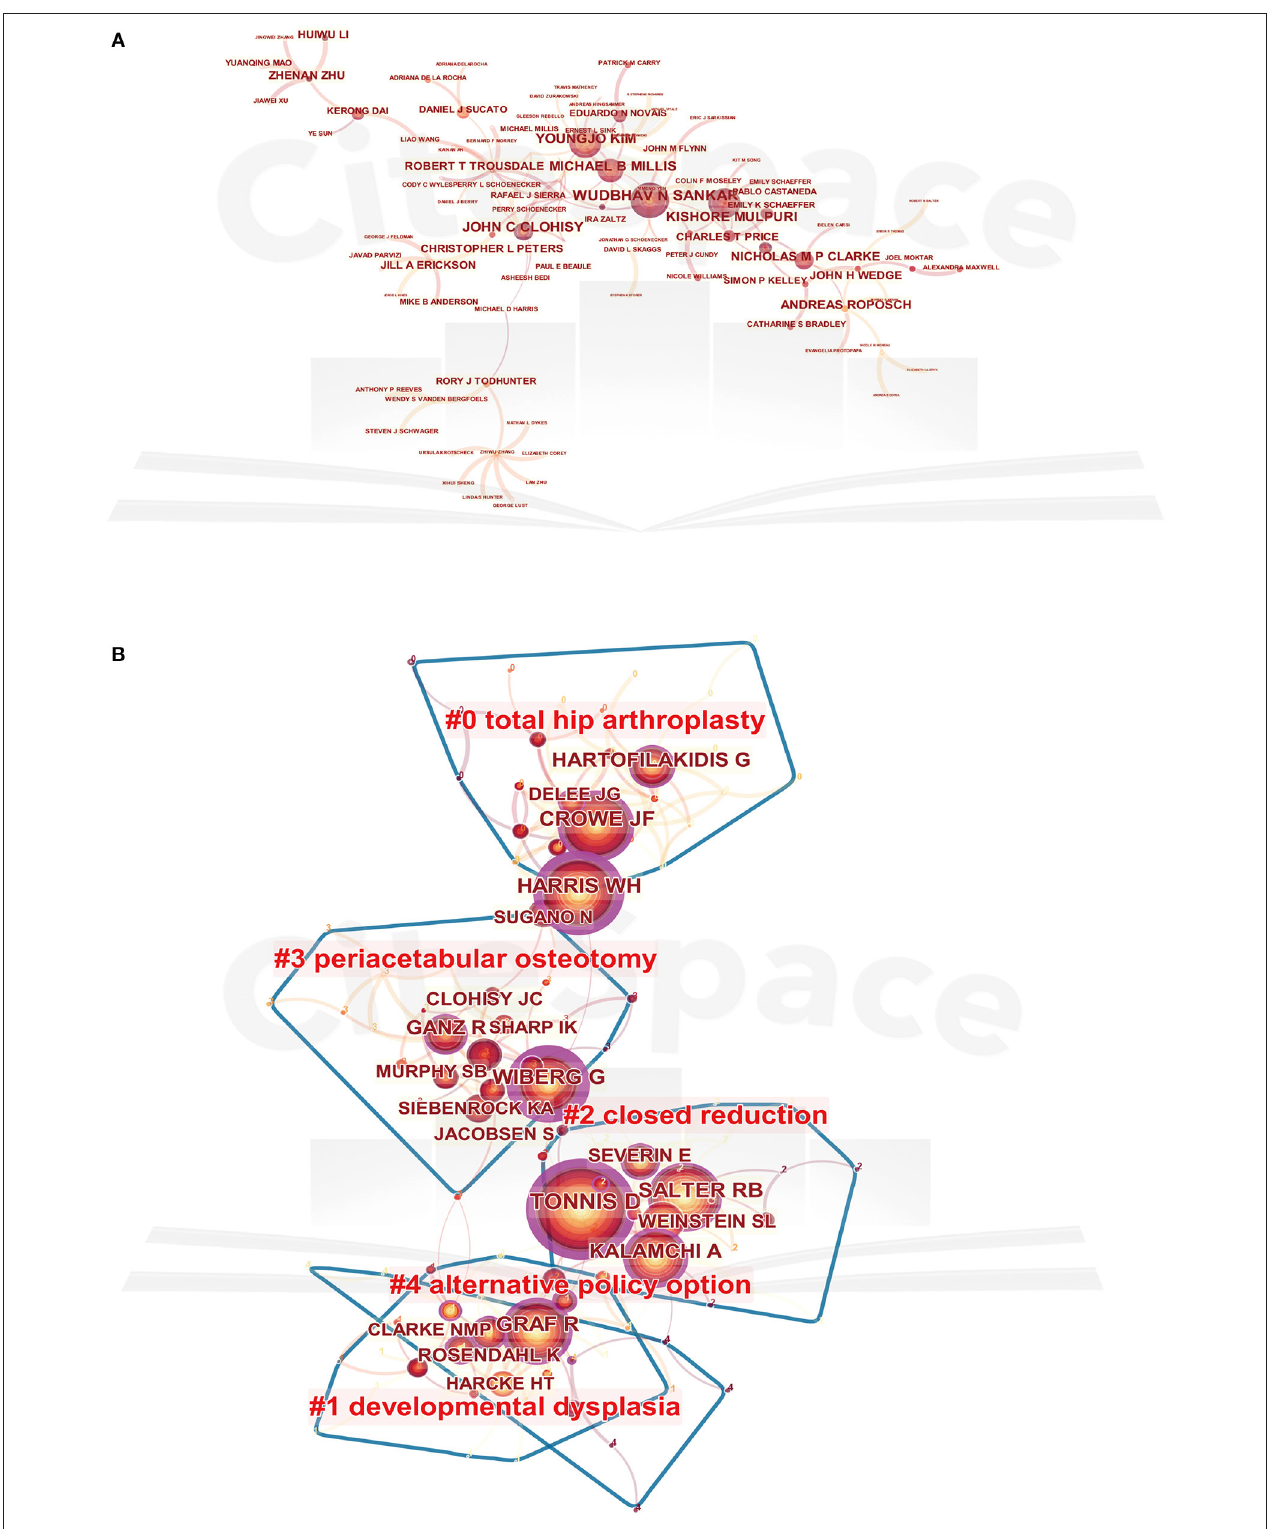
FIGURE 5 | The network map of authors cooperation (A) and the cluster view map of co-cited authors (B) . In the cluster map, cited authors with similar categories were gathered in a cluster. All the clusters were labeled in different colors, and the links between nodes represented elements cited together. Both of the maps were generated by